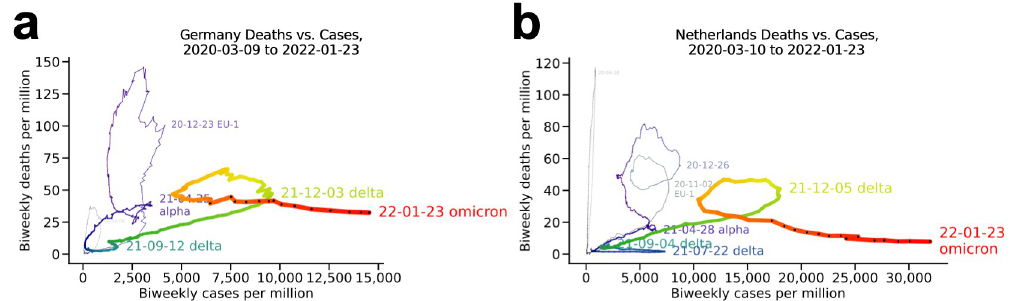
Fig 3. More European countries: Germany and the Netherlands. (a) Germany and (b) the Netherlands.